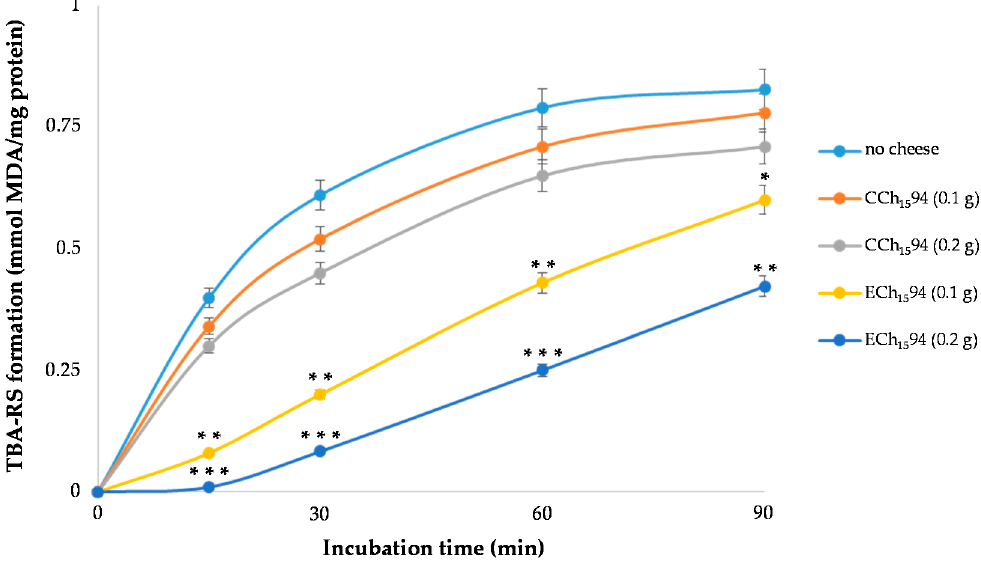
Figure 5. Time-course of thiobarbituric acid-reactive substances (TBA-RS) formation during the AAPH-induced microsomal oxidation, either in the absence (control) or in the presence of bioaccessible fraction obtained after in vitro digestion of cheeses. Microsomes, at 2 mg of protein per mL of reaction mixture, were submitted to peroxidation by AAPH as reported in the Materials and Methods. Each value is the mean ± SD of three determinations performed in duplicate. In comparison with the corresponding amount of GPP-free cheese, values are significant with * p < 0.05; ** p < 0.01; *** p < 0.0001. Abbreviations: CCh 15 94, control cheese after 15 d of refrigerate storage with L. lactis MISE94; ECh 15 94, experimental cheese after 15 d of refrigerate storage with 1% of GPP and L. lactis MISE94.